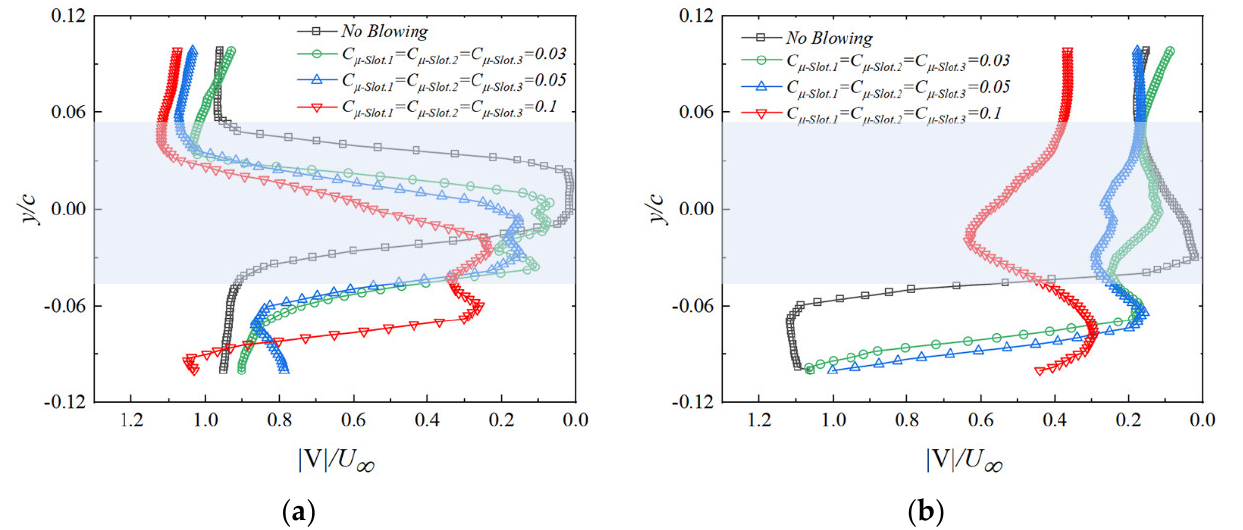
Figure 16. Near-field wake profiles with different blowing coefficients ( U ∞ = 8 m/s, x/c = 1). ( a ) AoA = 0°. ( b ) AoA = 20°.